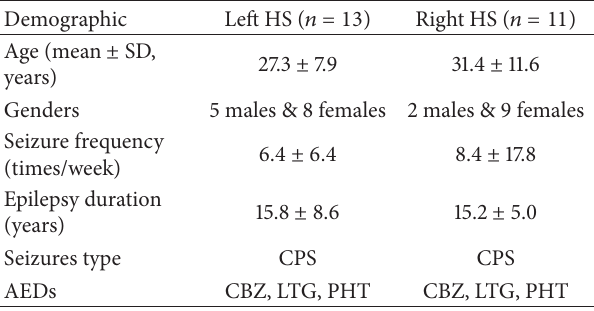
Table 1: Clinical and demographical data of the epilepsy patients.